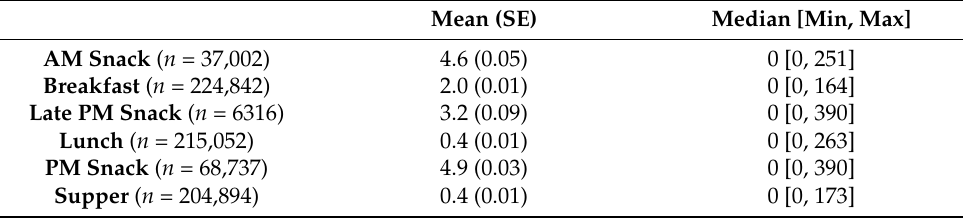
Table 7. Intakes of free sugars (g), by meal type. Mean, SE and median are